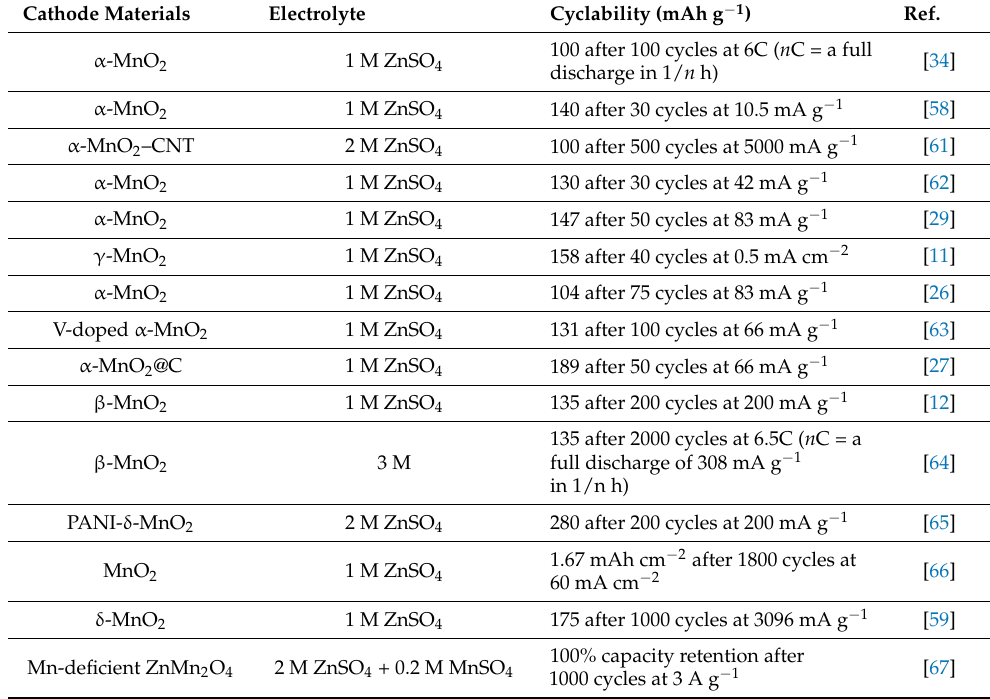
Table 1. The recent updates of Mn-based cathode